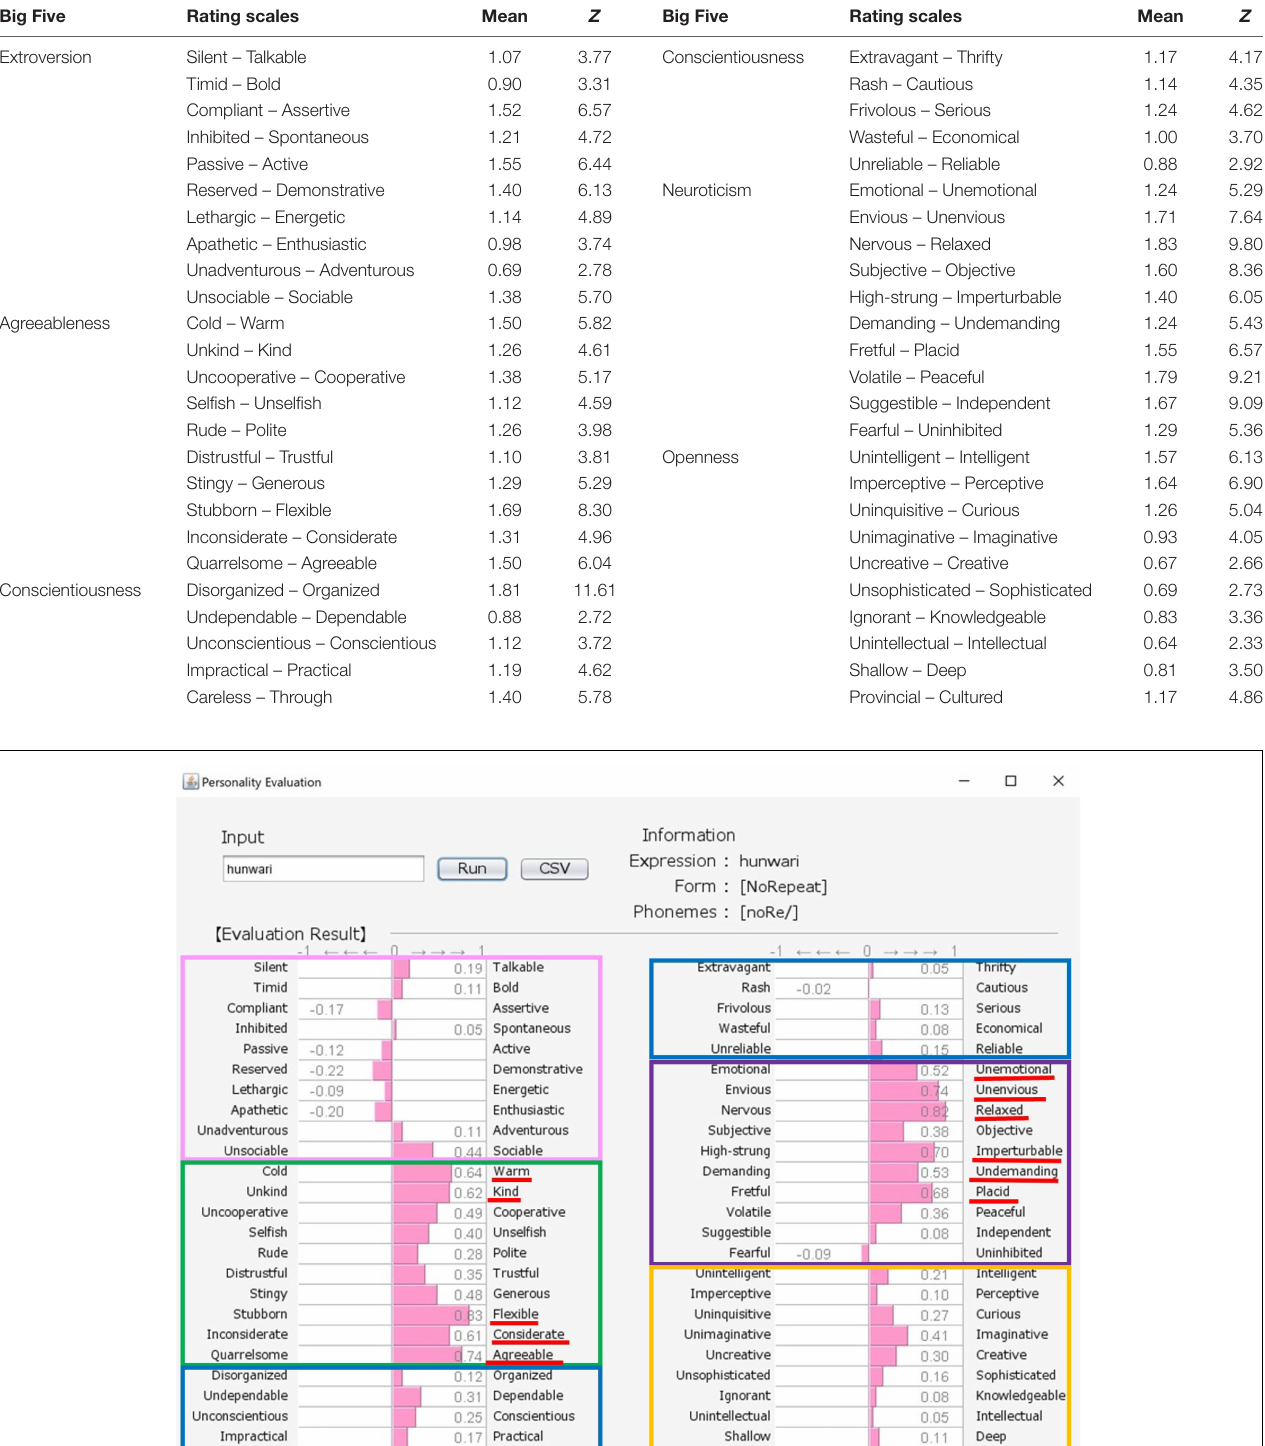
Frontiers in Psychology |